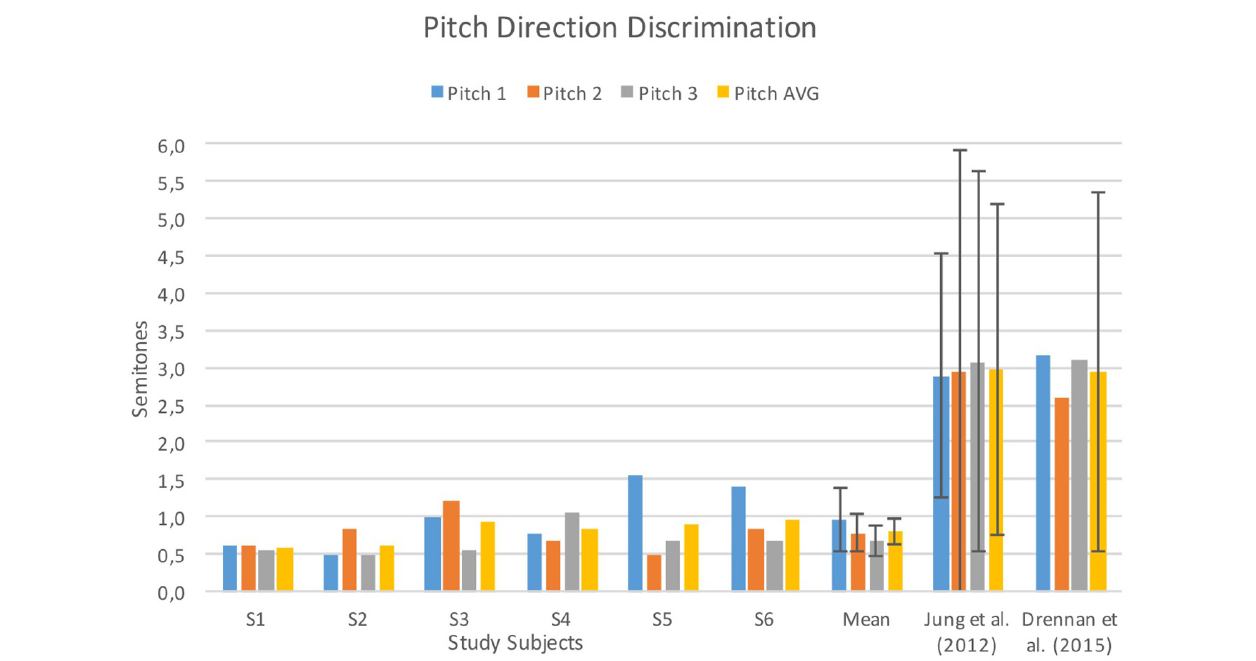
FIGURE 2 | Individual and mean pitch direction discrimination scores for study subjects and mean scores from previous studies. Error bars indicate ± 1 standard deviation. AVG, average. Data adopted from Jung et al. (2012) and Drennan et al. (2015).